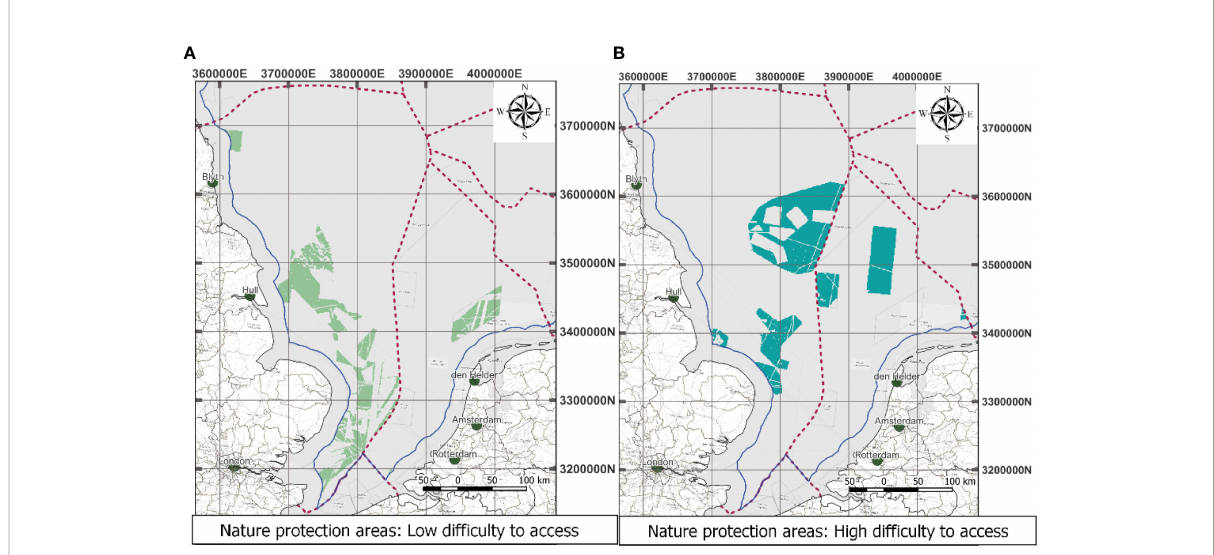
FIGURE 16 Areas of distinct focus for management strategies with nature protected sites: (A) low dif fi culty to access (low ACS/1 or 2 overlaps); and (B) high dif fi culty to access (high ACS/2 or 3